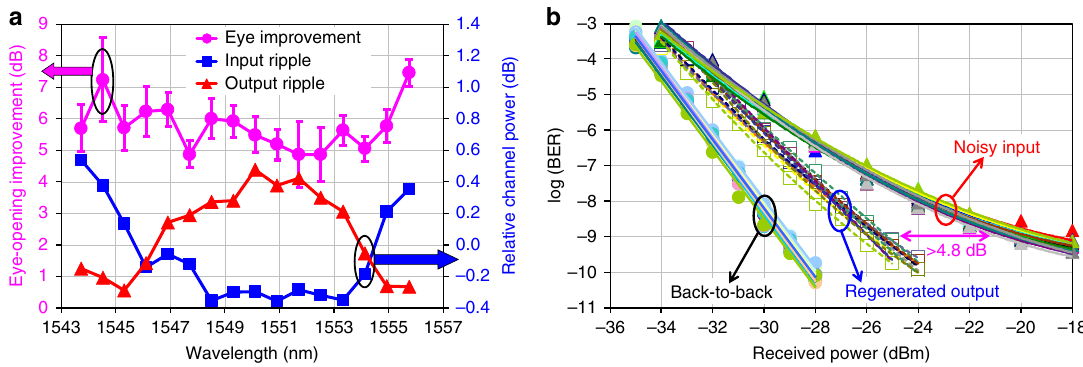
Fig. 7 BER measurements and spectral ripple before and after the stand-alone 2R regenerator. a Eye-opening improvements at BER = 10 − 9 level ( purple circles pertaining to the left axis) and spectral ripple ( blue squares and red triangles pertaining to the right axis) among the 16 simultaneously regenerated channels. By pre-emphasising the channel powers so that the ripple of the WDM spectrum at the GDM medium input ( blue squares ) is the inverse of that at the GDM medium output ( red triangles ), we minimise the differences in optical signal-to-noise ratios and nonlinear phase shifts among the 16 channels due to Raman gain ripple 66 . Error bars are obtained from the parabolic fi ts to BER curves. b BER curves for all 16 channels